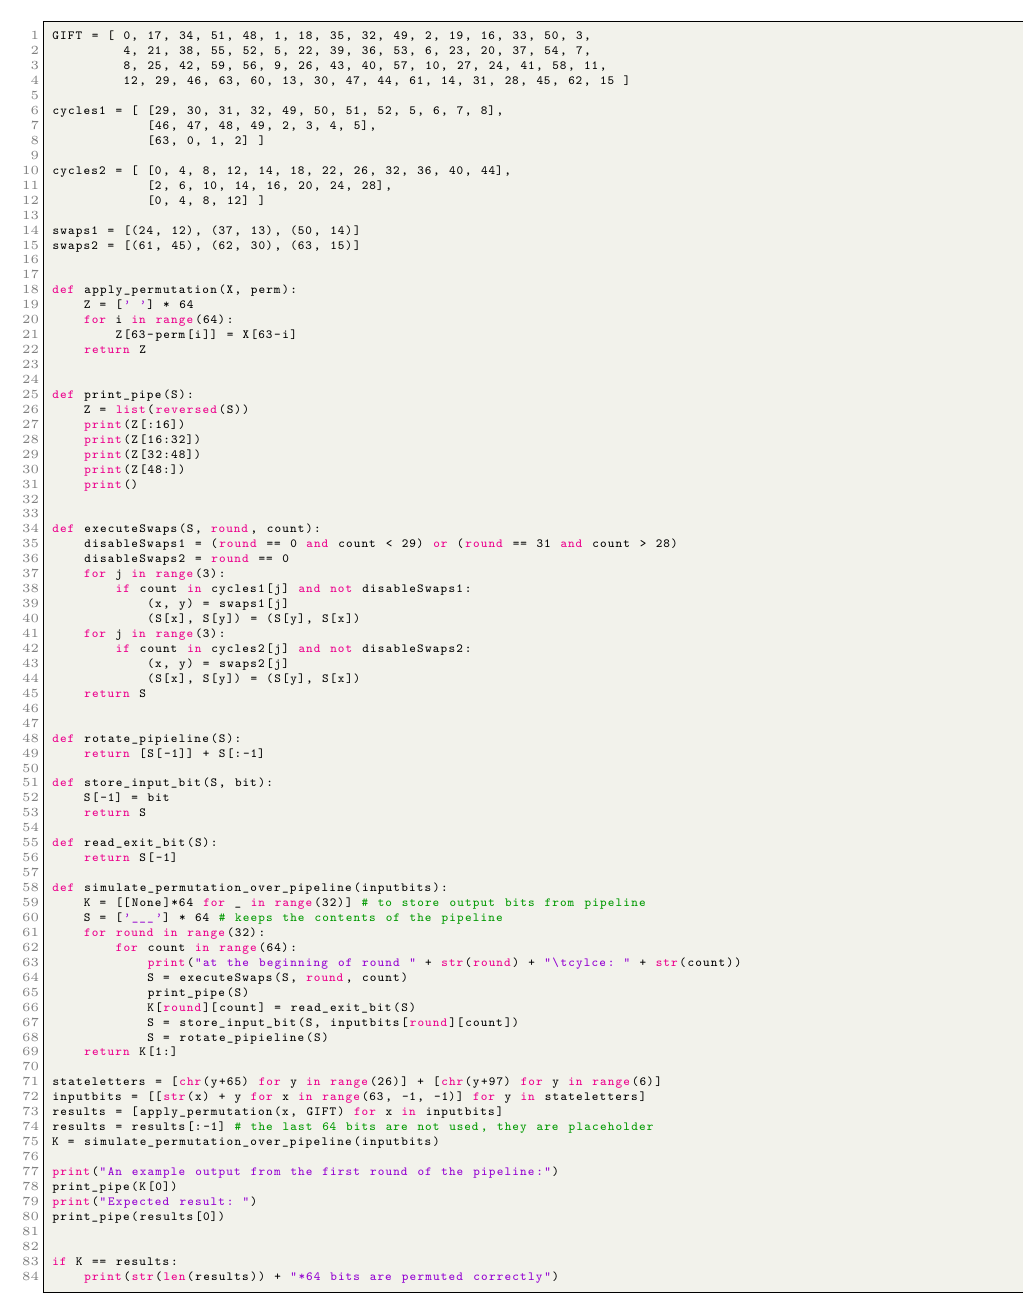
Figure 16: Example code for GIFT permutation using 6 swaps in 64 cycles.